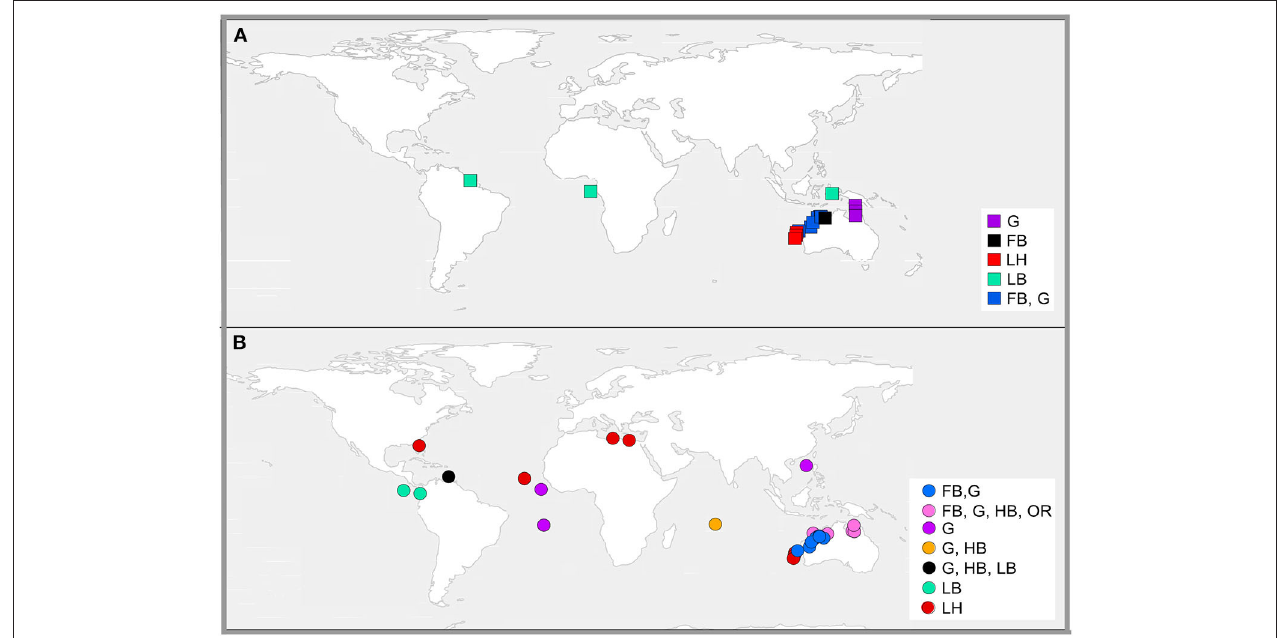
FIGURE 3 | Locations where mechanistic models [square symbols, (A) ] and correlative models [circle symbols, (B) ] have been used to predict sand or nest temperature at turtle rookeries. Symbol colors represent the focal species nesting at each site, where FB, flatback; G, green; HB, hawksbill; LB, leatherback; LH, loggerhead; and OR, olive